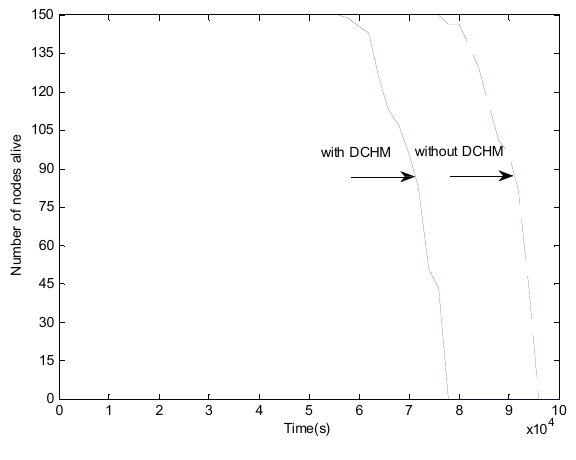
Figure 17. Number of nodes alive over